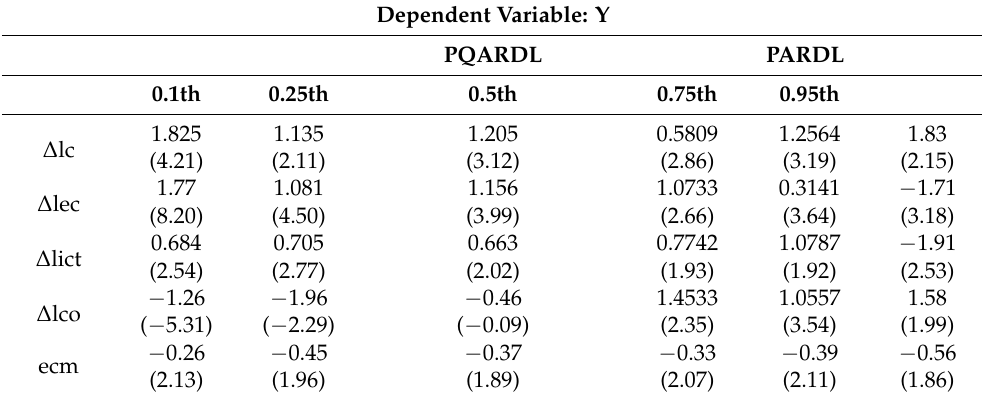
Table 8. Short-run PQARDL and PARDL